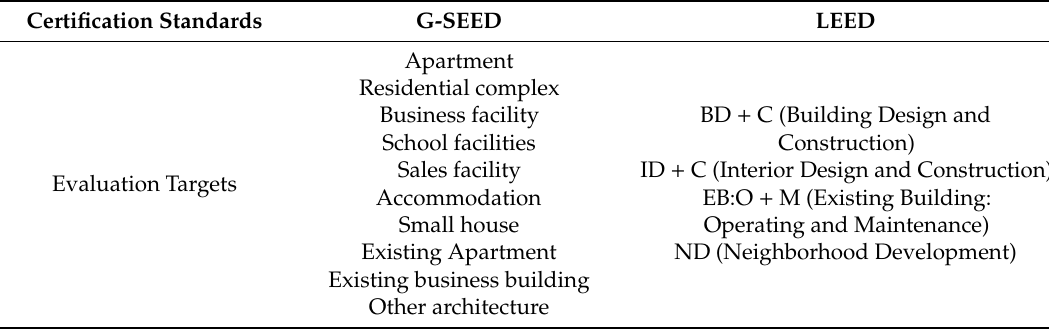
Table 3. Comparison of G-SEED and LEED Evaluation